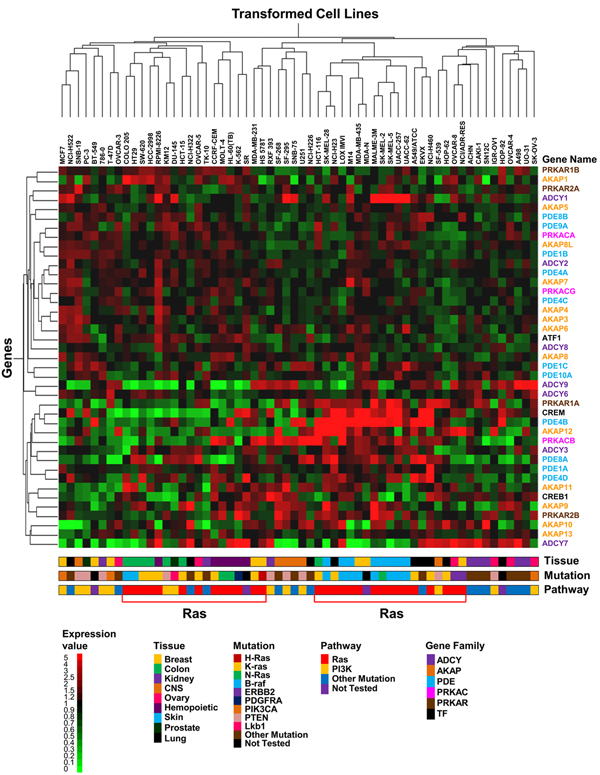
Hierarchical clustering of the 41 PKA pathway-encoding genes in transformed samples. Two-way (gene, column and cell line, row) hierarchical clustering (see Methods) of the profiles from the NCI60 collection only. Normalized expression is colour-coded from green (poor expression) to red (strong expression). The distance function is based on Pearson correlation and complete linkage clustering. The name of each gene is colour-coded according to the family to which it belongs. Legends for expression, condition, gene family and tissue of origin are shown on the right of the dendrogram. The data have been organized on the basis of the tissue of origin of the cancer (Tissue), the specific oncogenic mutations identified in each cell line (Mutation), the putative altered pathway by the specific mutations (Pathway) and the gene family.